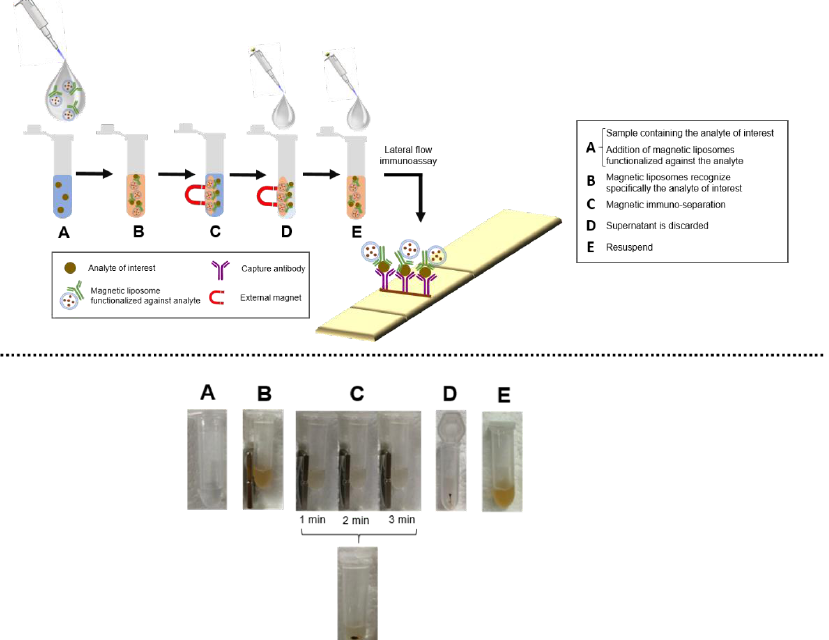
Figure 6. Process of immuno-separation, including the different steps schematically and with photographs. ( A ) Solution with the analyte. ( B ) Immuno -separation with a conventional magnet using magnetic liposomes. ( C ) Immuno-separation after 1 min, 2 min and 3 min. ( D ) Pellet after immune-separation. ( E ) Pellet resuspended with buffer.